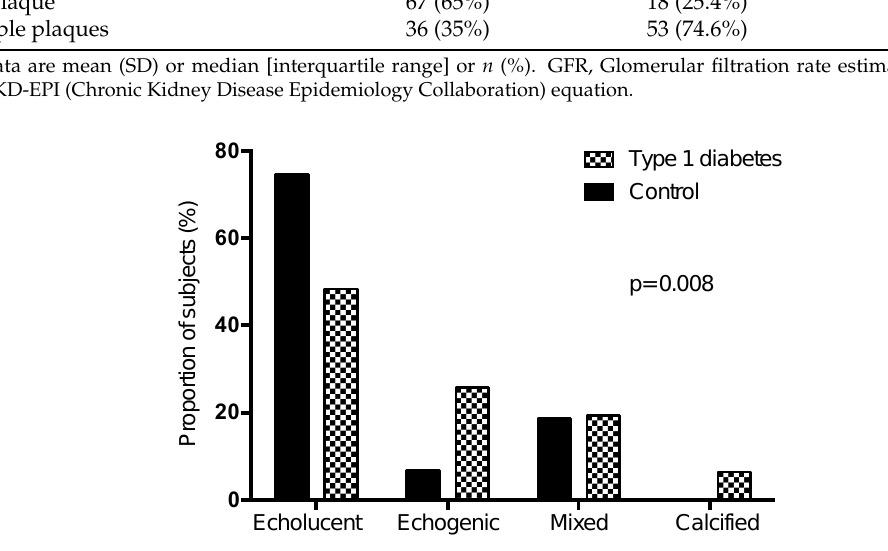
Figure A1. Proportion of patients without statin treatment with different types of atherosclerotic plaque (only echolucent, only echogenic, mixed of echolucent and echogenic plaques, and calcified with or without another plaque type), n = 90.